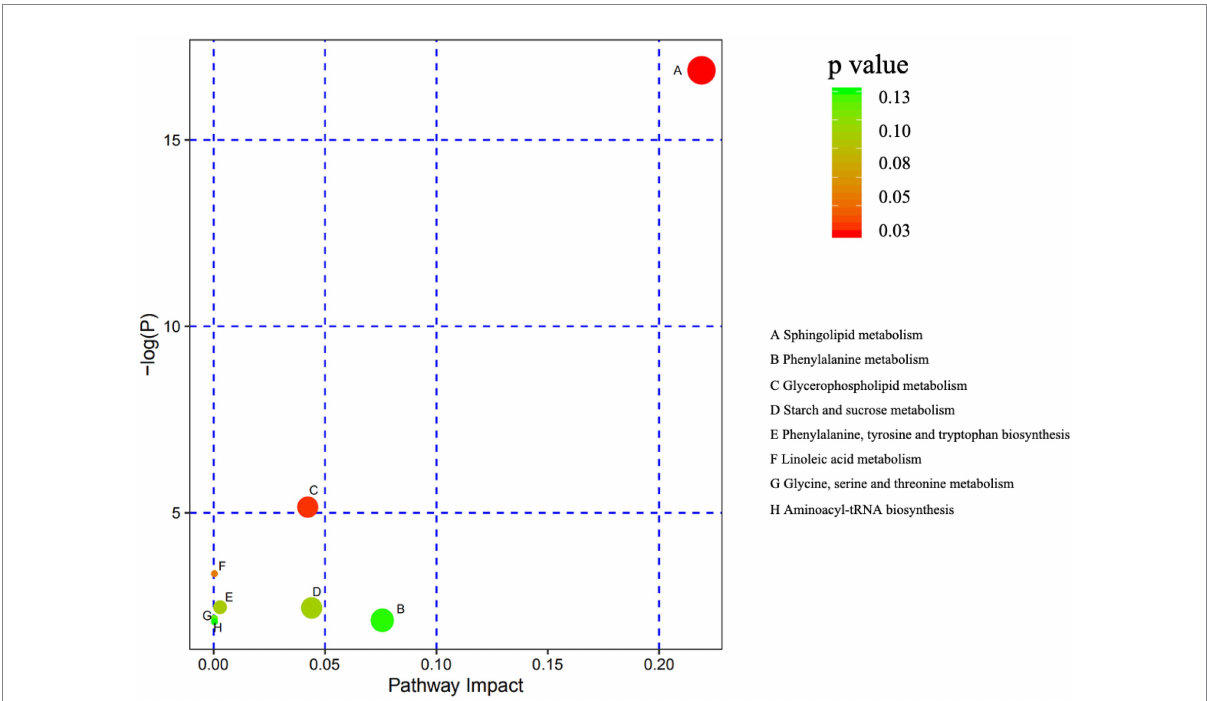
FIGURE 6 Metabolome mapping of the differences in metabolite expression from day 1 to day 7. The abscissa shows pathway impact and the ordinate gives the p value. The bigger the circles the greater the number of metabolites enriched in the pathway. Darker colors indicate smaller p values ( n =